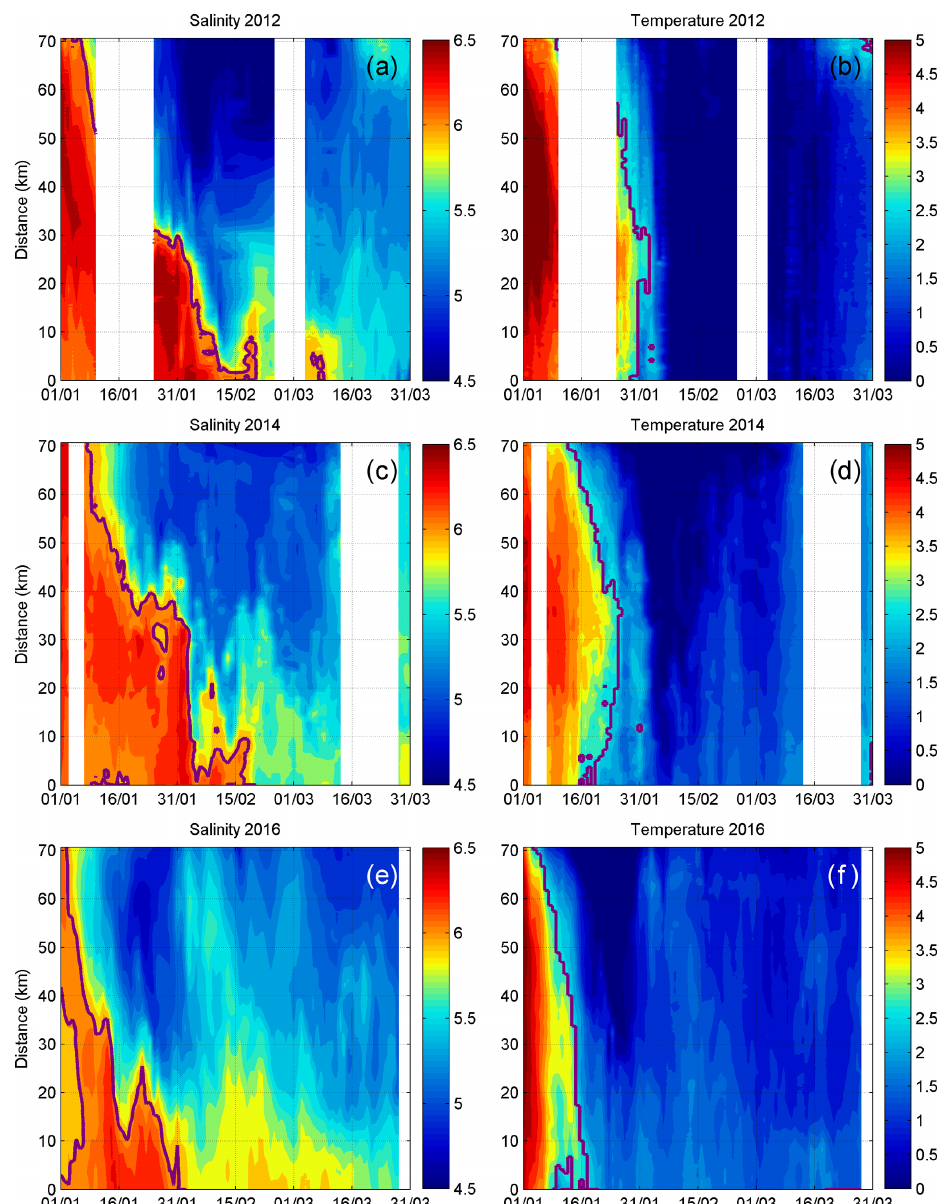
Figure 6. Salinity gkg − 1 (a, c, e) and temperature ( ◦ C) (b, d, f) of the upper layer along a transect from Tallinn to Helsinki (red line in Fig. 1) in January–March 2012, 2014, and 2016. The isoline 6gkg − 1 is marked on the salinity plots and the maximum density temperature T md on the temperature plots. The starting point of the transect ( x ) = 0km is in the Bay of Tallinn at 59500 ◦ N and 24752 ◦